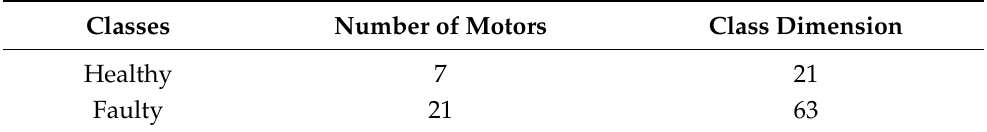
Table 3. Dataset exploited for the cross validation.